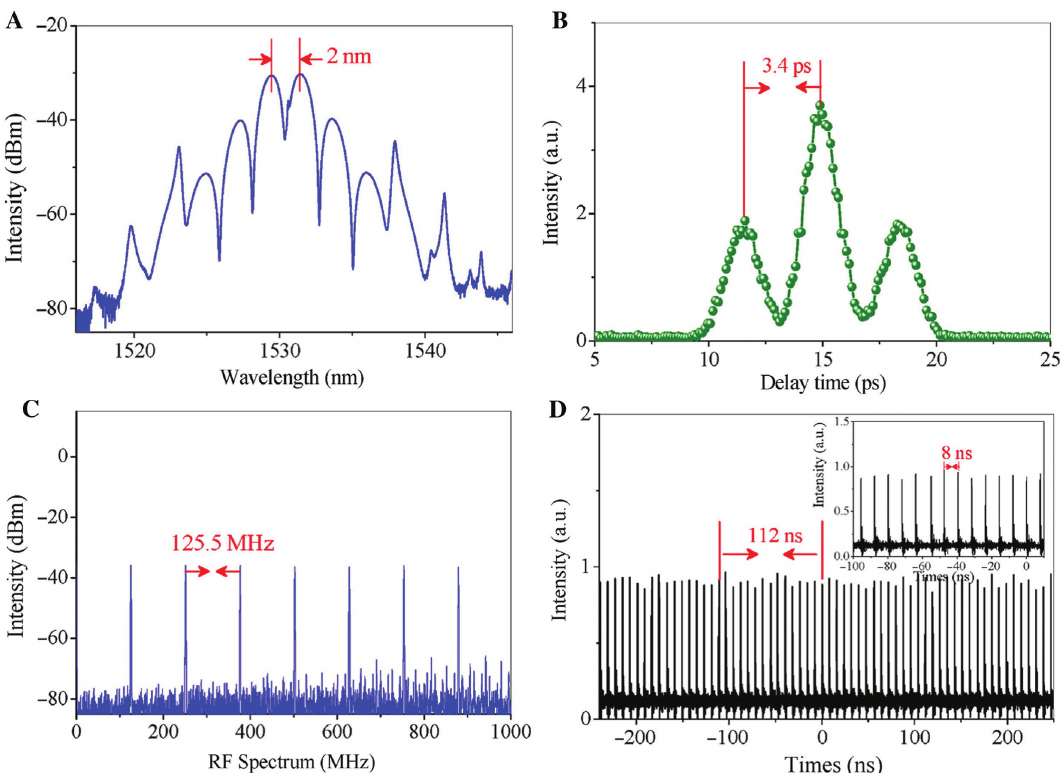
Figure 5: (A) Spectrum, (B) auto-correlation trace, (C) radiofrequency spectrum, and (D) oscilloscope trace of harmonic mode locking (HML) pulses based on MoS -D-shaped fiber (DSF) saturable absorber (SA). 2 Reproduced with permission. Copyright 2015 The Optical